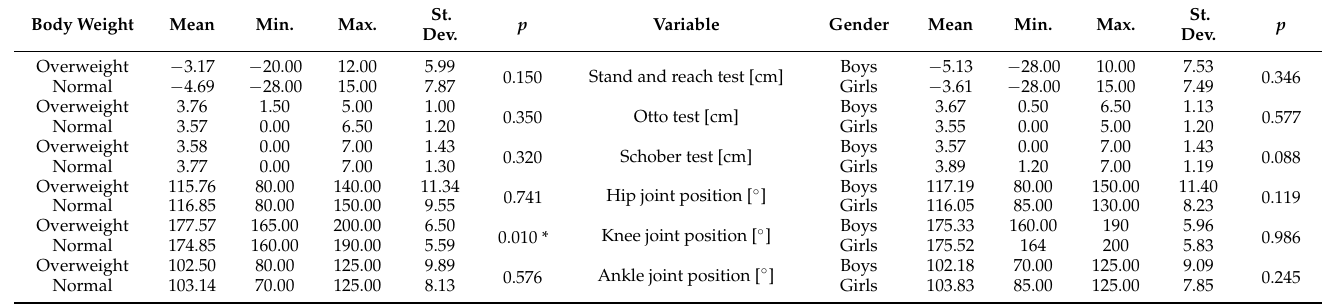
Table 3. Comparison of the position of the individual segments of the legs and the spine in the forward